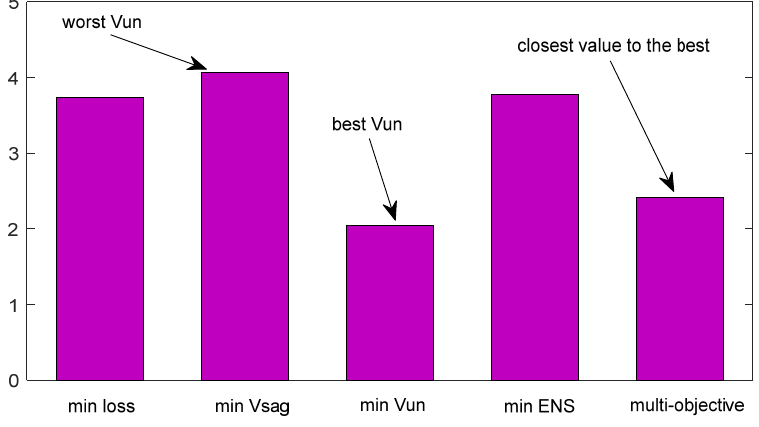
Figure 8. The voltage unbalance in single-criterion and many-criteria optimizations using AEFAPS.